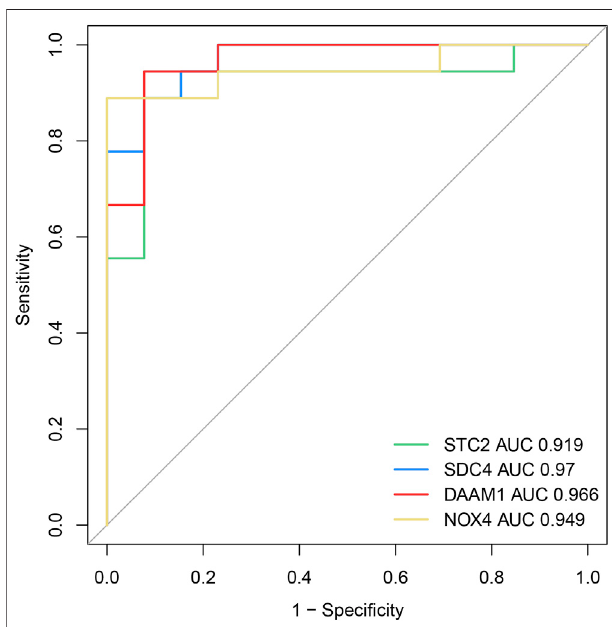
FIGURE 7 | The diagnostic ef fi cacy of the four diagnostic markers were evaluated by the ROC curve analysis.